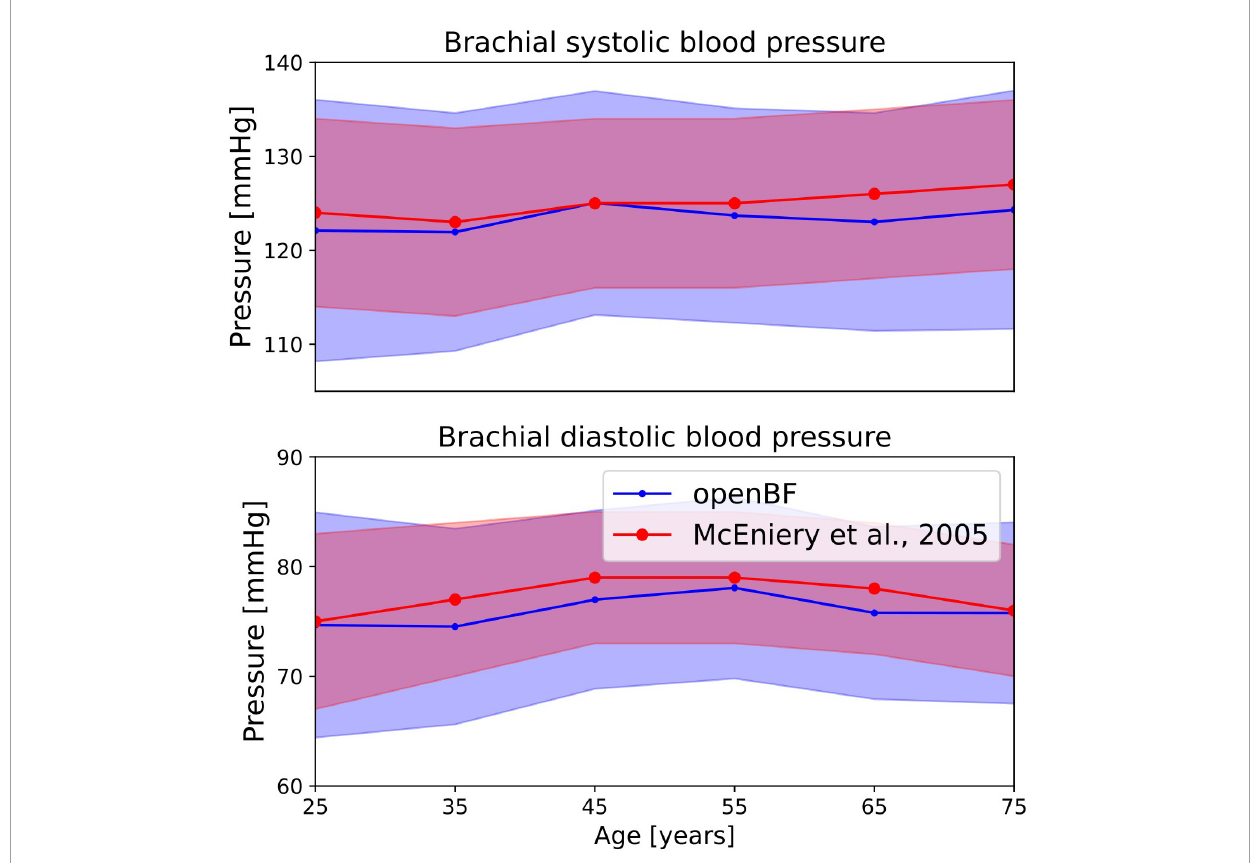
FIGURE4 Outcome of the ageing model, comparison of brachial pressure against experimental data from McEniery et al. (37). Simulation results are shown in blue, validation points are in red. Solid line indicates the mean values while shaded areas represent one standard